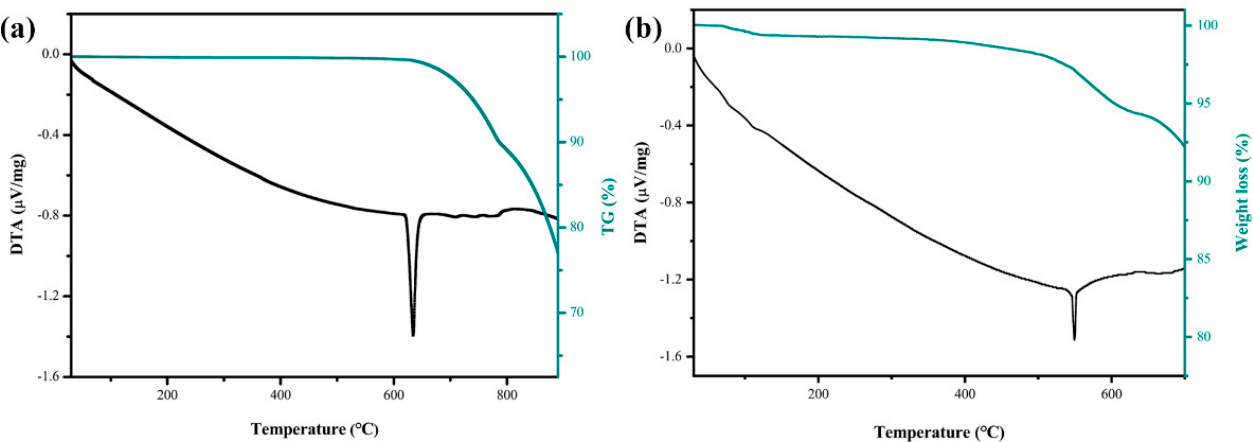
Figure 3. TG-DTA curves of ( a ) CKLC and ( b ) CKCC crysta ls.